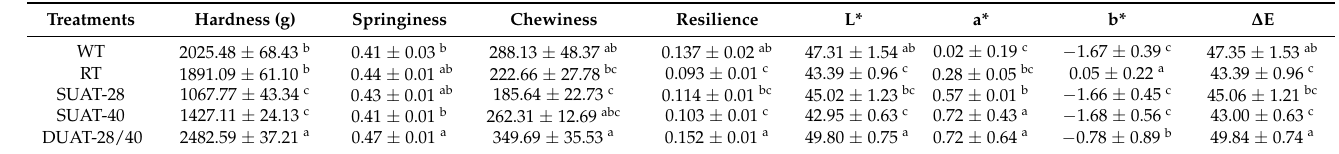
Table 2. Differences in hardness, springiness, chewiness, resilience, L*, a*, b*, and ∆ E of large yellow croaker under different thawing